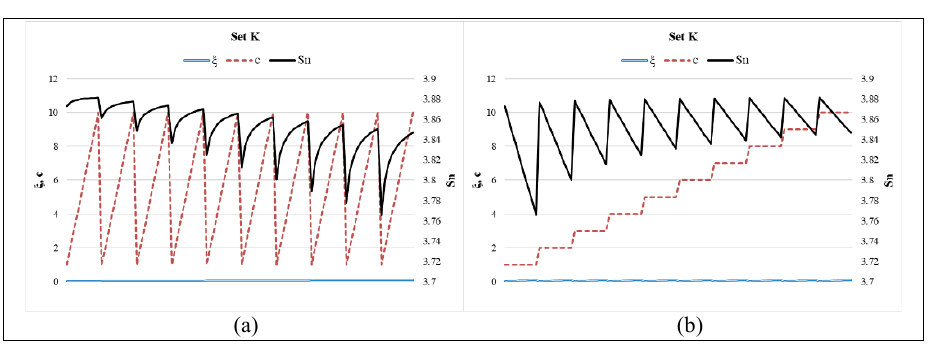
Fig. 2. The wealth 𝑆 2500 obtained by running the universal portfolio (13) on the data set K for 0.01 ≤ 𝜉 ≤ 0.1 and 1 ≤ 𝑐 ≤ 10 . The series 𝜉 and 𝑐 are plotted on the primary axis while series 𝑆 𝑛 is plotted on the secondary axis.